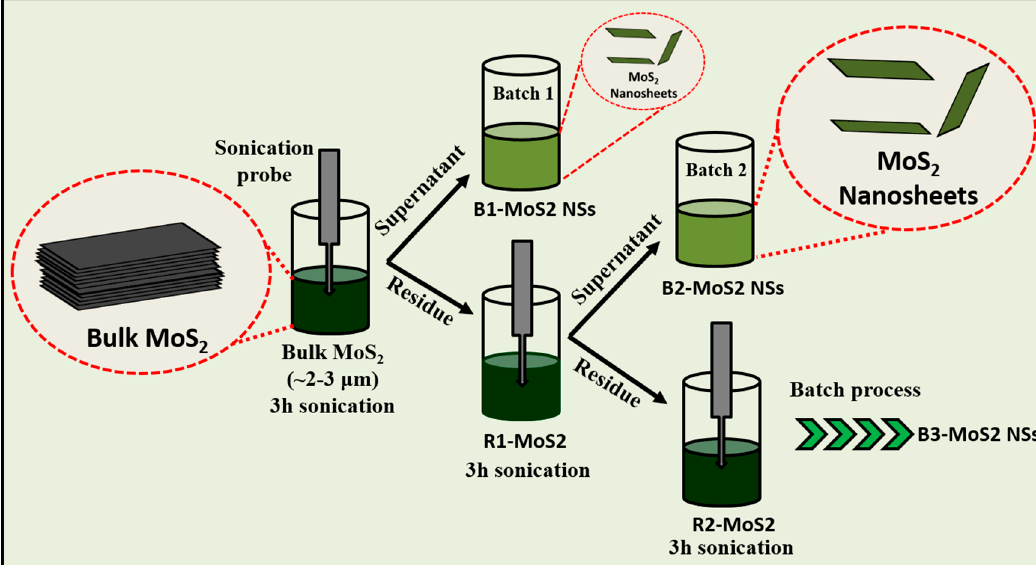
Figure 1 . Schematic representation of batch manner synthesis of MoS 2 NSs . Figure 1. Schematic representation of batch manner synthesis of MoS 2 NSs. Catalysts 2020 , 10 , x FOR PEER REVIEW